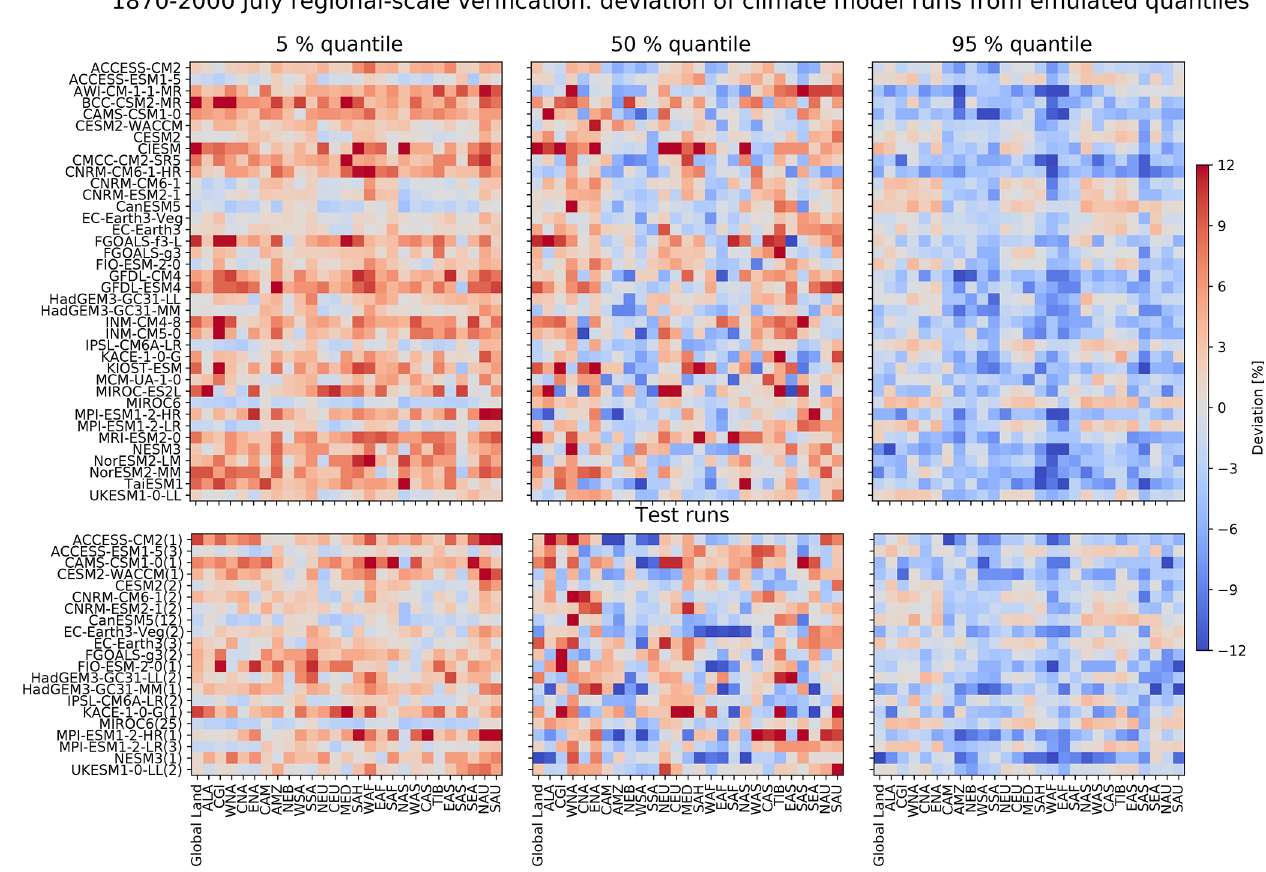
Figure 9. Same as Fig. 8, but for July over the period